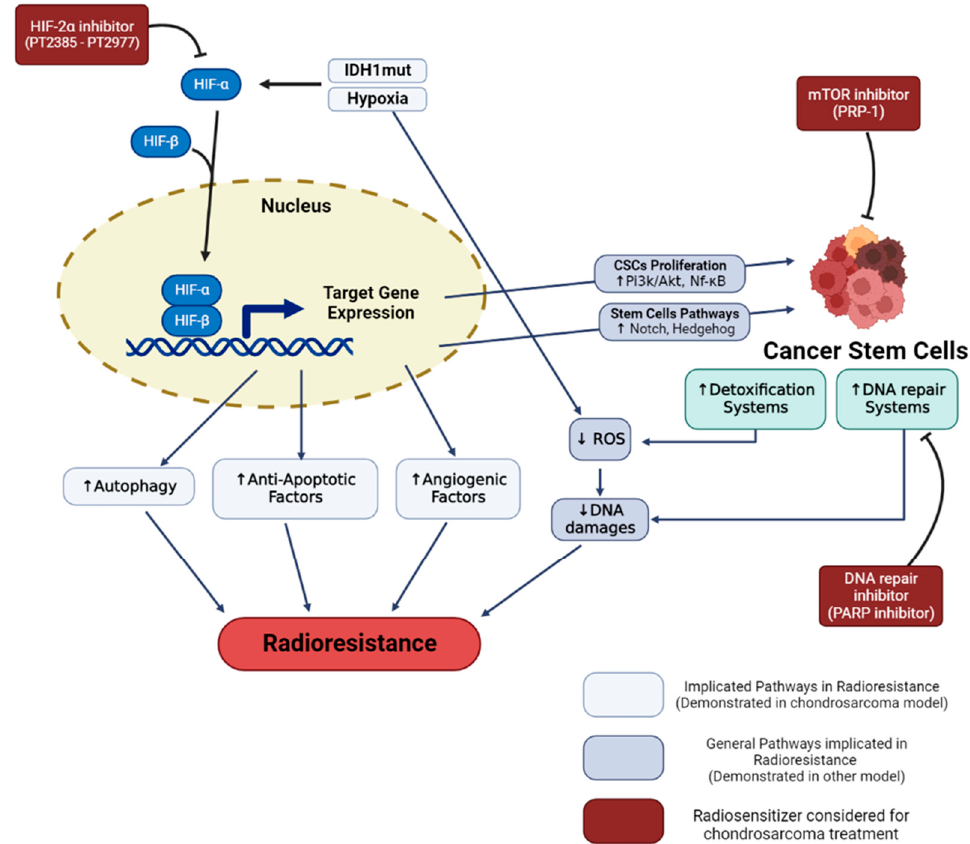
Figure 1. Hypoxia and cancer stem cells radioresistance in chondrosarcoma. Hypoxia and IDH-1 mutation lead to HIF-1 α and HIF-2 α stabilization. These regulated pathways enhance cell radiore- sistance and increase the proportion of cancer stem cells. Specific inhibitors (in red), such as HIF-2, PARP, and mTOR inhibitors demonstrated a capacity to reverse cell resistance and are considered in order to radiosensitize chondrosarcomas.